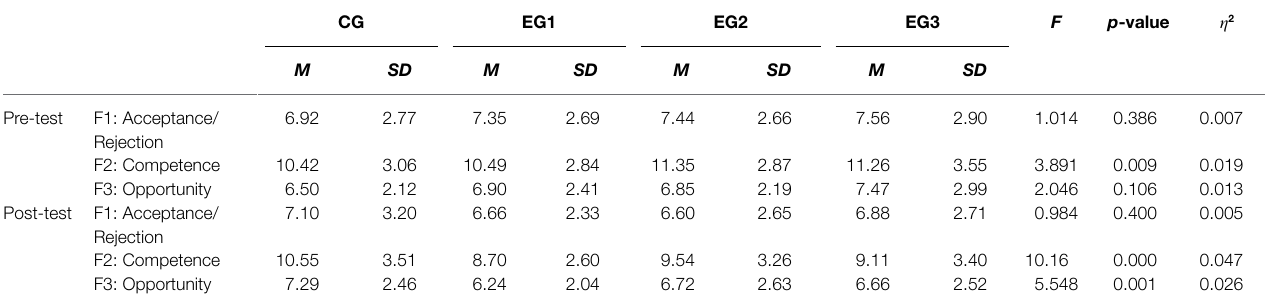
TABLE 3 | Inter-group analysis.